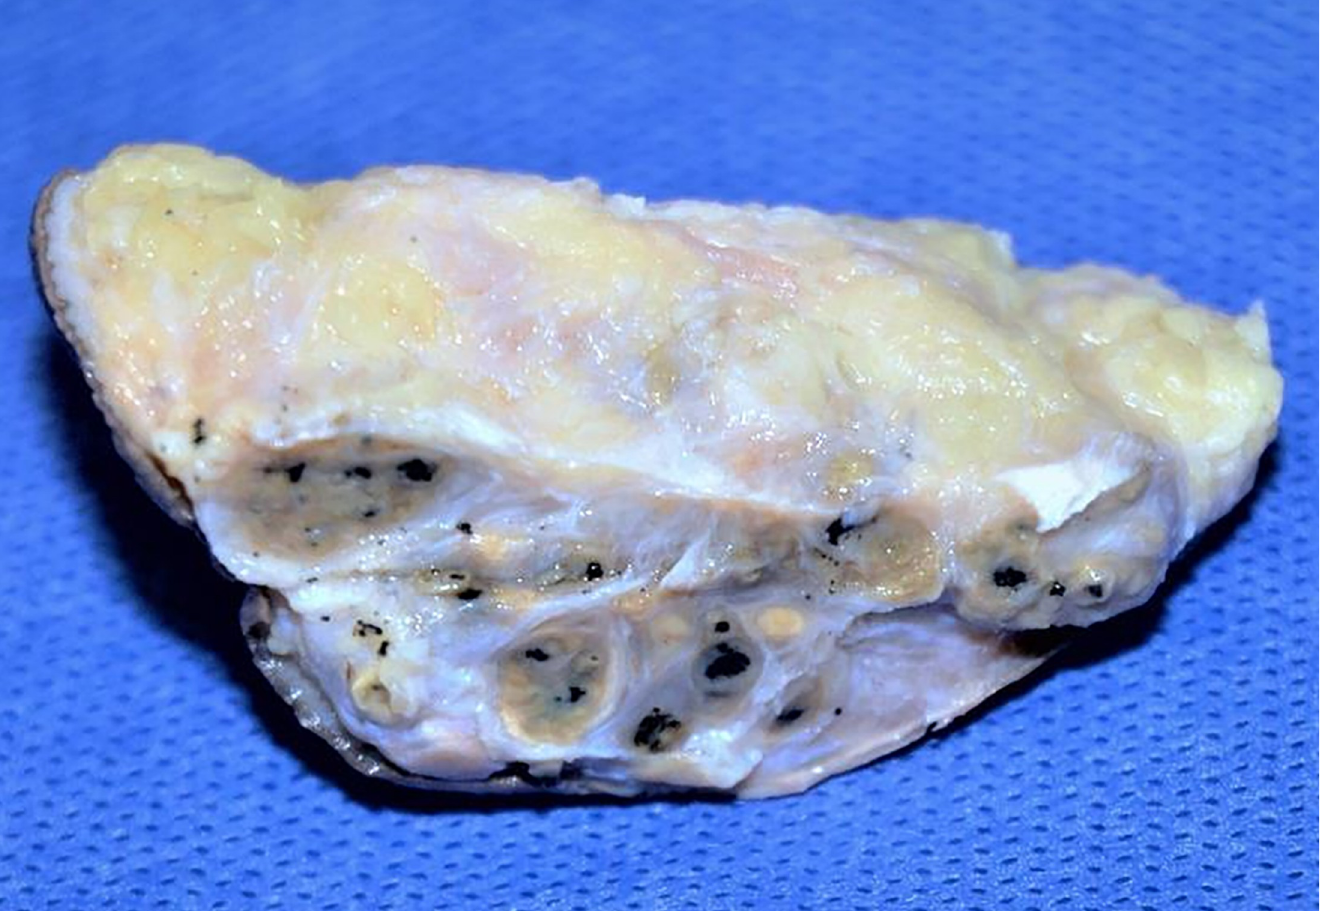
Fig 1. Microphotograph showing the grossing appearance of the lesion that showed multiple black grains.